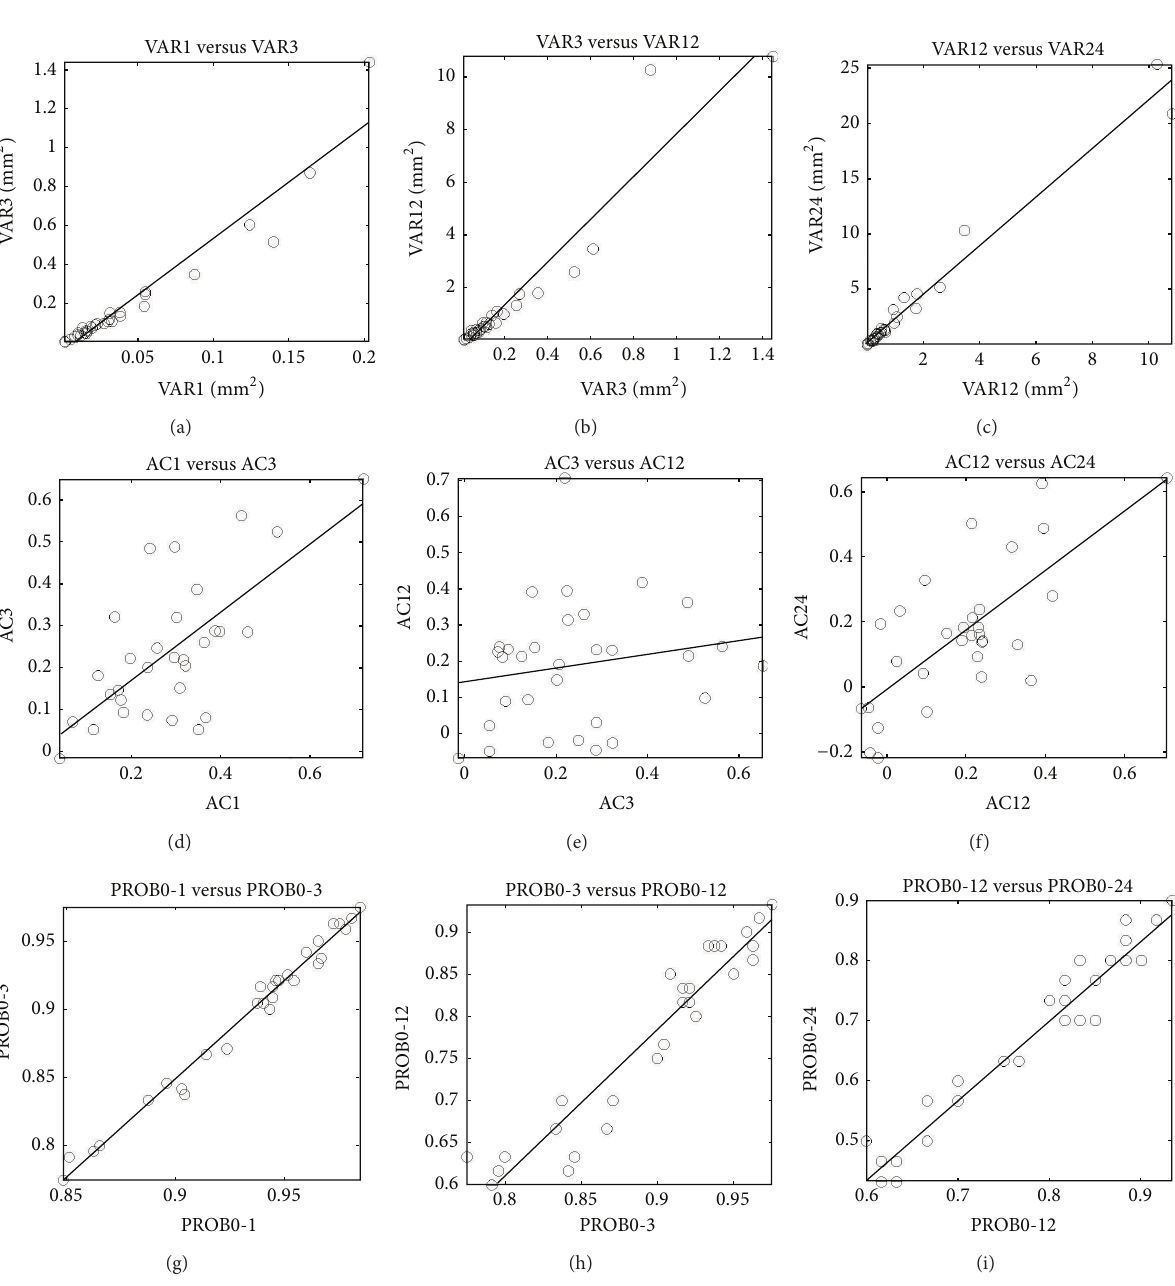
Figure 8: Relationship between the rainfall statistics at 1, 3, and 12 hourly accumulation levels and the least square regression lines at the gauge TX-4300 for the month of